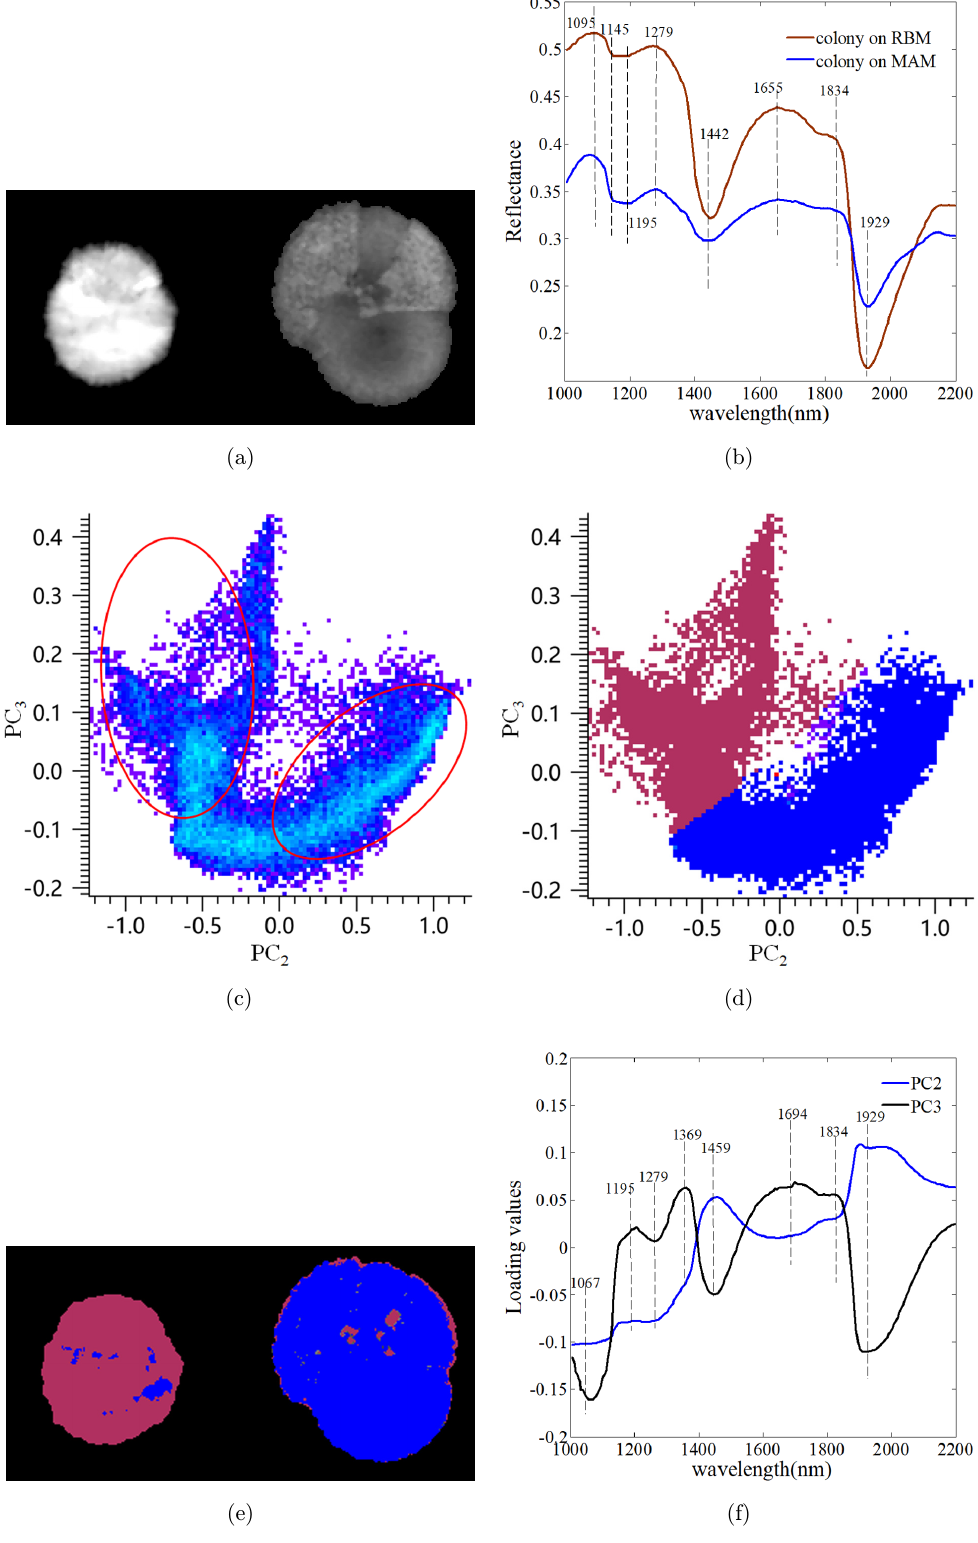
Fig. 8. Analysis of colonies on di®erent media. (a) Gray image of the mosaic. Colony grown on RBM was on the left, and colony on MAM was on right. (b) Average spectra of each colony. (c) Score plot of PC 2 and PC 3 . (d) Two identi¯ed clusters. (e) Classi¯cation projected onto the score image. (f) Loading line plot of PC 2 and PC 3